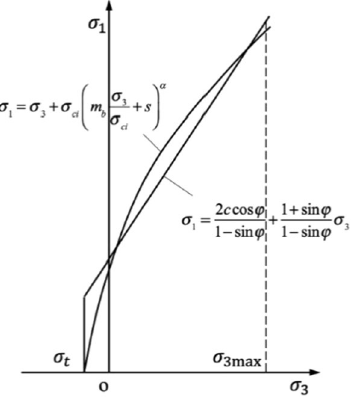
Figure 1. Relationships between HB and equivalent MC